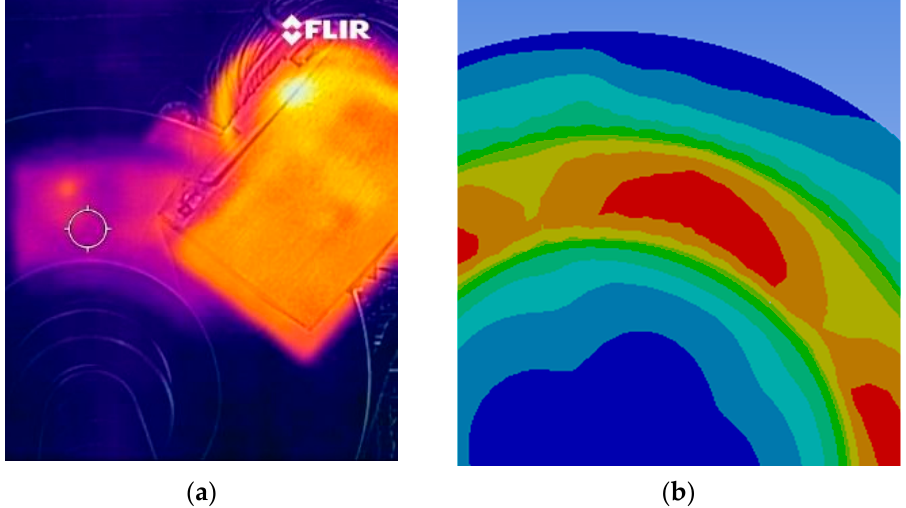
Figure 8. Distribution of heat generated on the surface of the ECB disc: ( a ) Experiment, ( b ) Modeling.